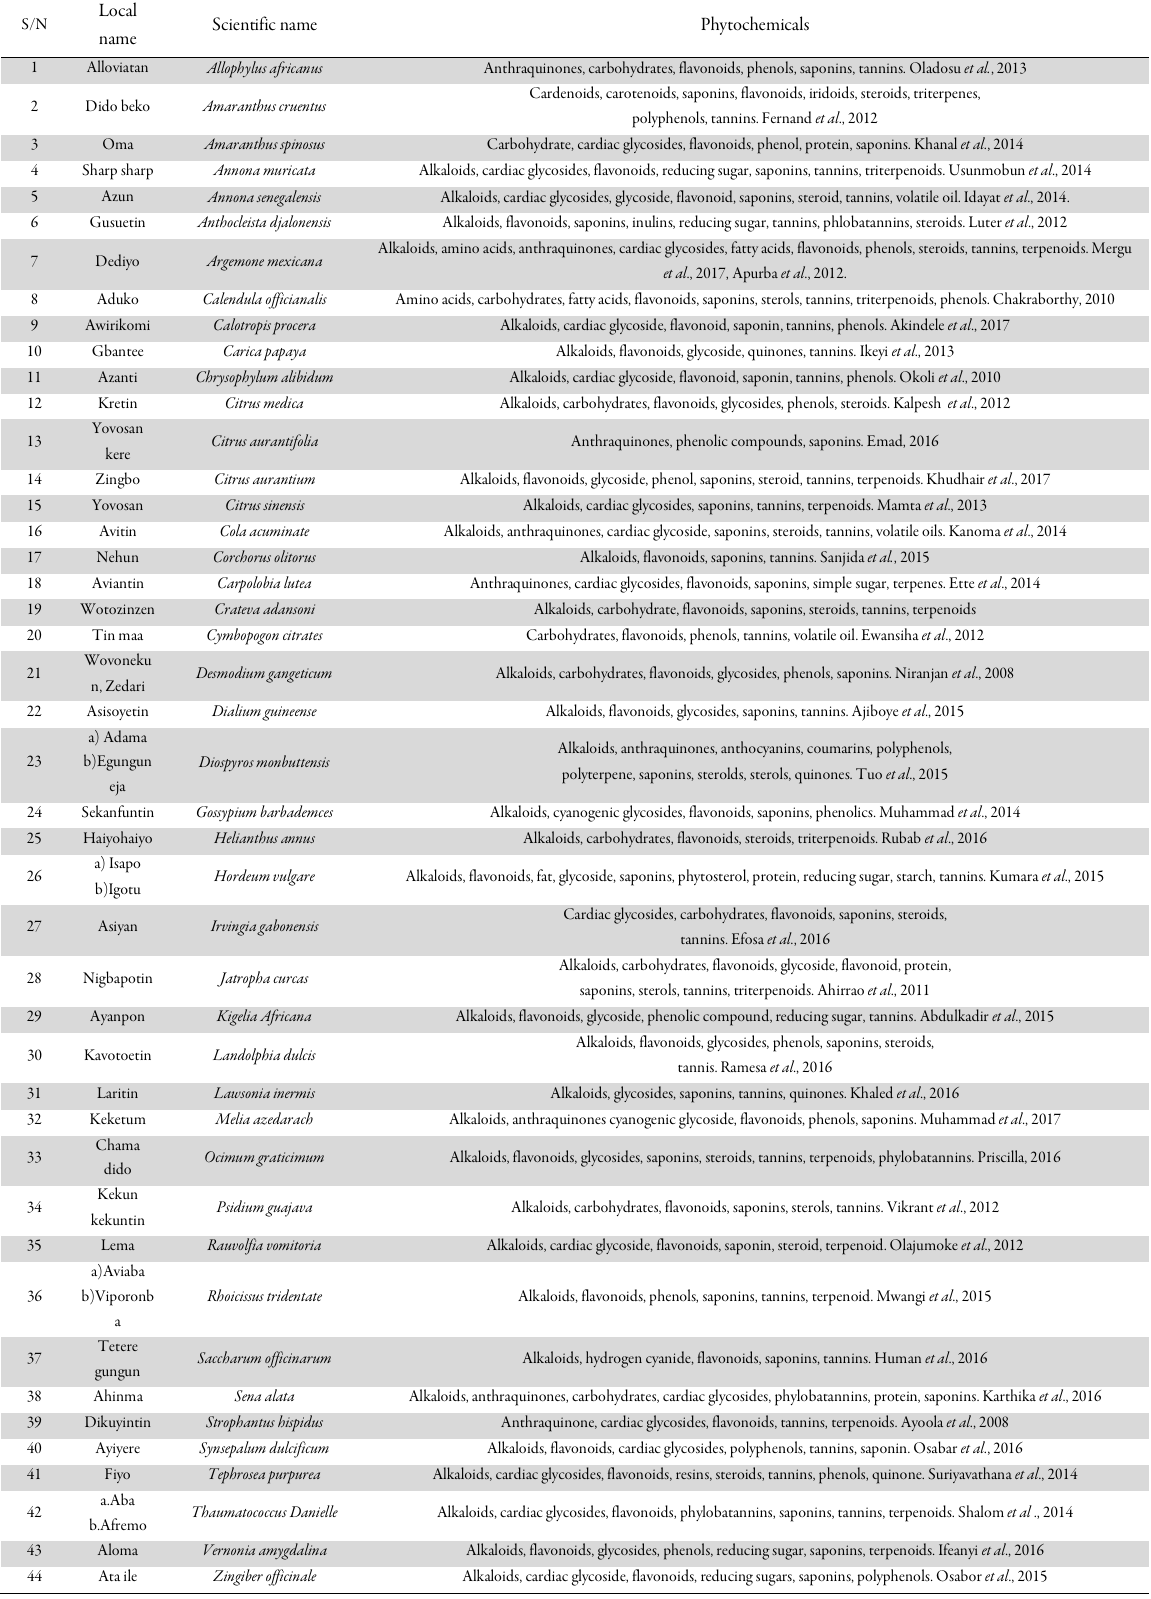
Table 3. Phytochemical constituents present in the identified plant species used as medicine